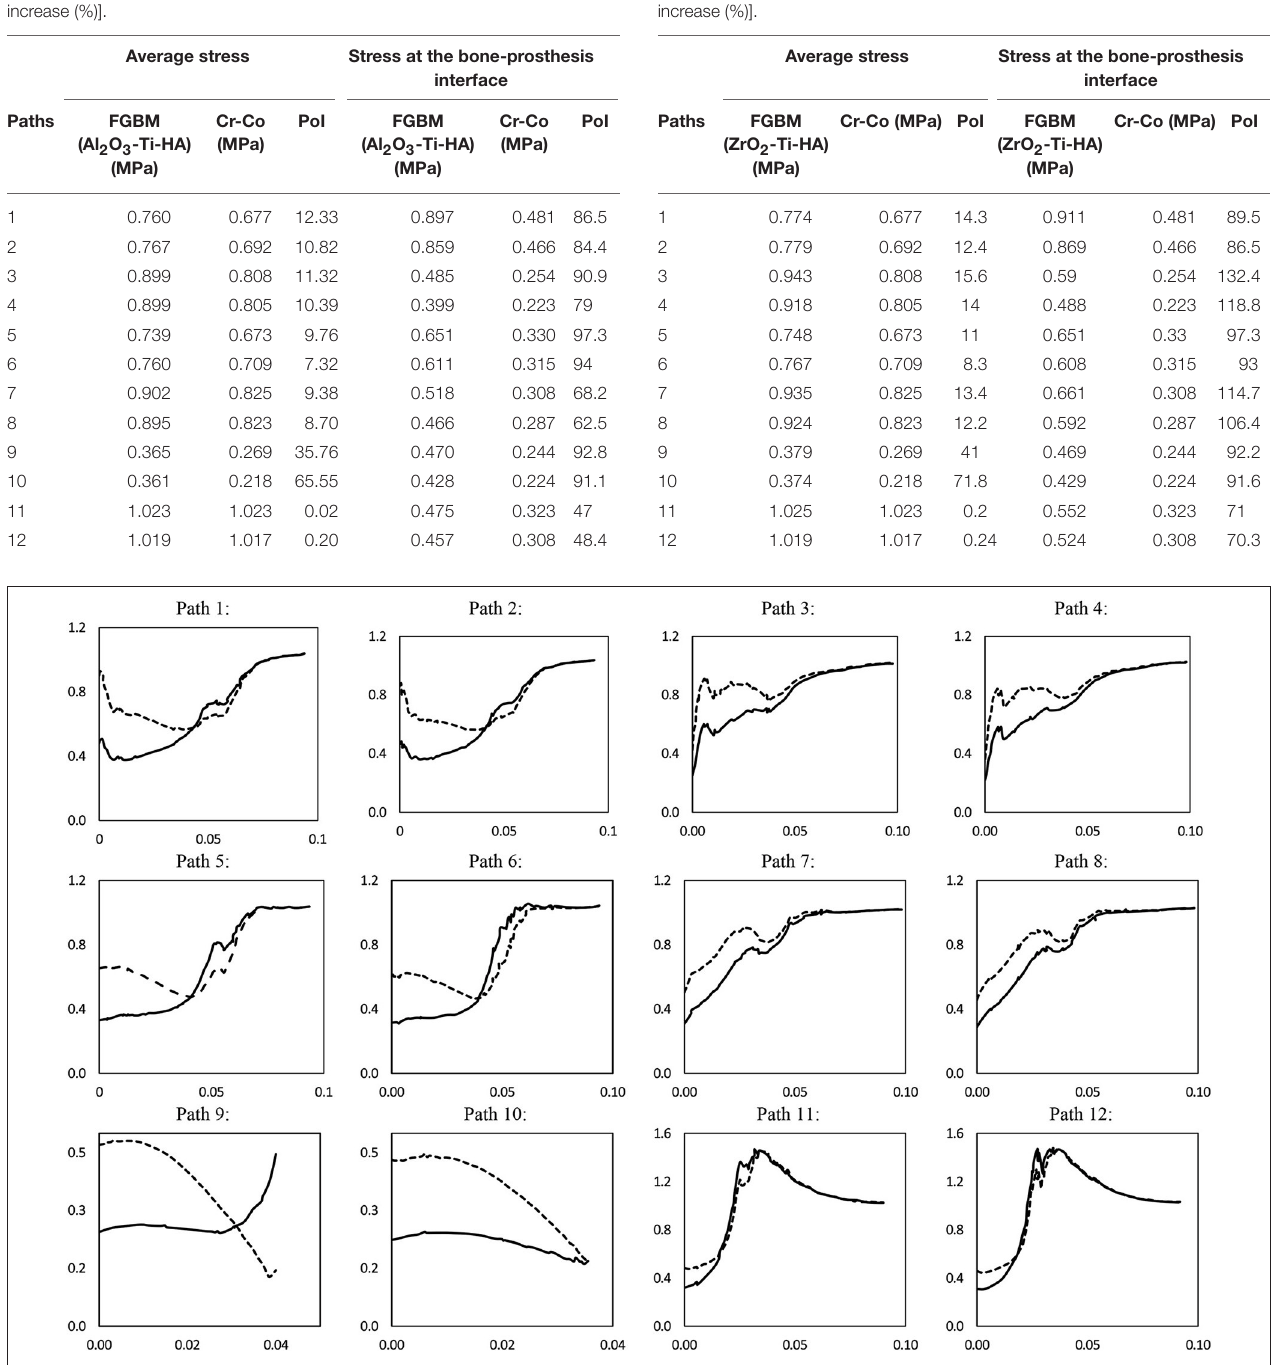
FIGURE 4 | Von Mises stress (MPa) vs. proximal distance from the interface (m) in response to the all paths for both Cr-Co (solid line) and alumina-based proposed FG biomaterial (dashed line).